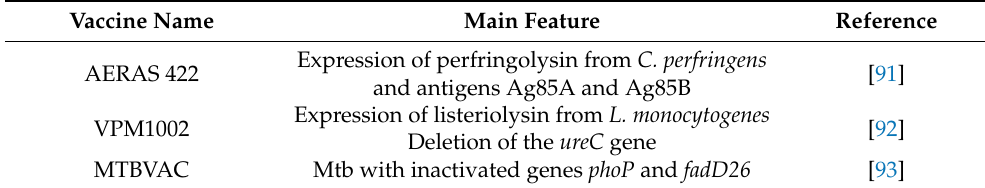
Table 1. Recombinant live vaccines under clinical